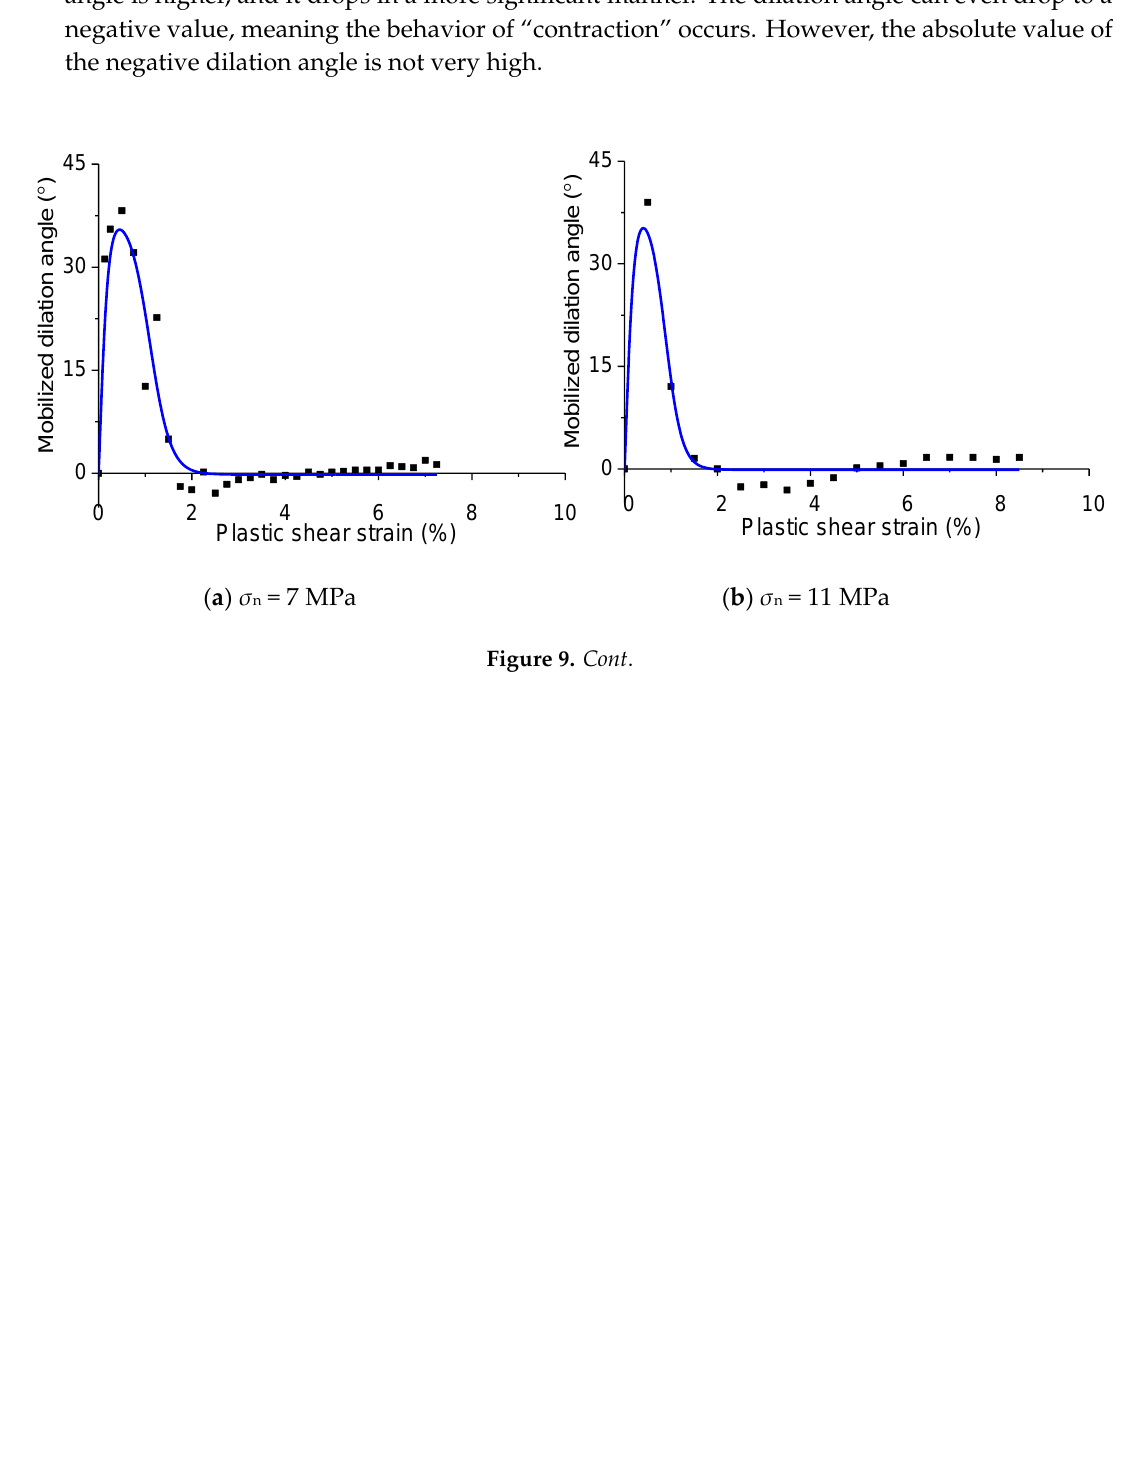
Figure 8. Plastic shear and plastic normal strain relations of the granite samples under different normal stresses.